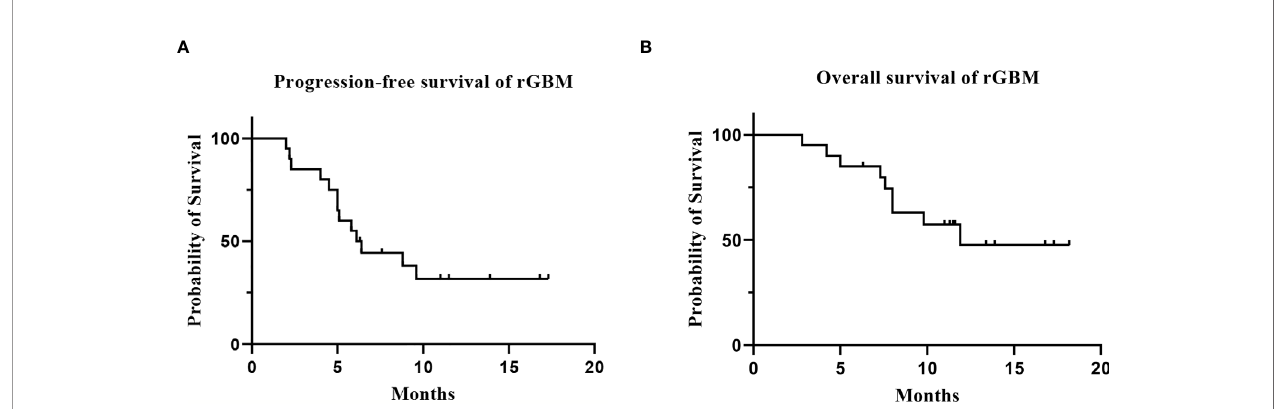
FIGURE 1 | The survival analysis of the 20 patients with rGBM who received anlotinib and TMZ treatment. [ (A) progression-free survival; (B) overall